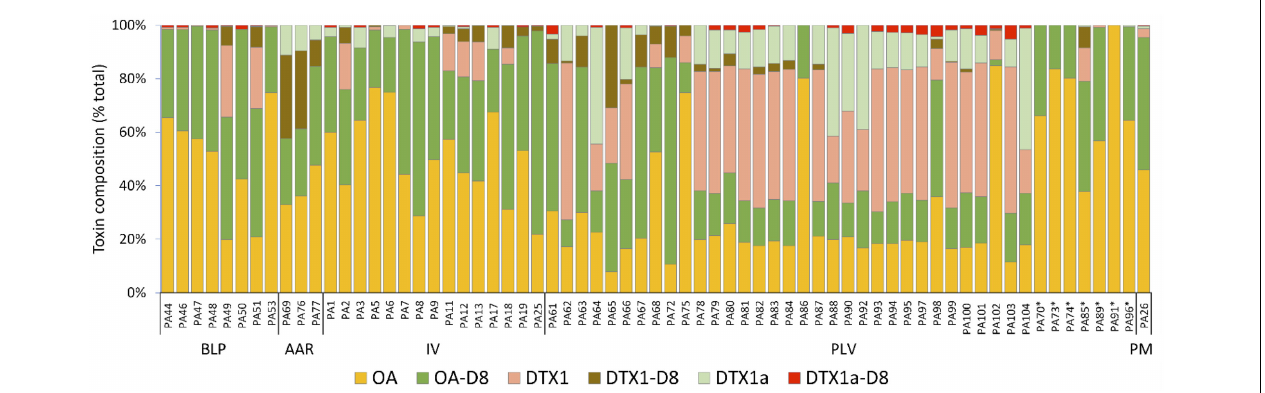
FIGURE 5 | Relative composition (% total) of DSP toxins (OA and DTX analogs) in isolates ( n = 67) of the P. lima complex (PLSC) and P. hoffmannianum (indicated by ∗ asterisk) from the Gulf of California, Gulf of Mexico, and Caribbean coasts of Mexico. BLP, BCS = Bahía de La Paz, Baja California Sur; AAR, VRS = Anegada de Adentro Reef, Veracruz Reef System, Veracruz; IV, VRS = Isla Verde, Veracruz Reef System, Veracruz; PLV, VRS = Piedra de La Virgen, Veracruz Reef System, Veracruz; PM = Puerto Morelos, Quintana Roo. Toxin acronym codes: OA = okadaic acid; OA-D8 = okadaic acid diol-ester; DTX1: dinophysistoxin 1; DTX1-D8 = dinophysistoxin 1 diol-ester; DTX1a = undescribed isomer of DTX1; DTX1a-D8: undescribed isomer of